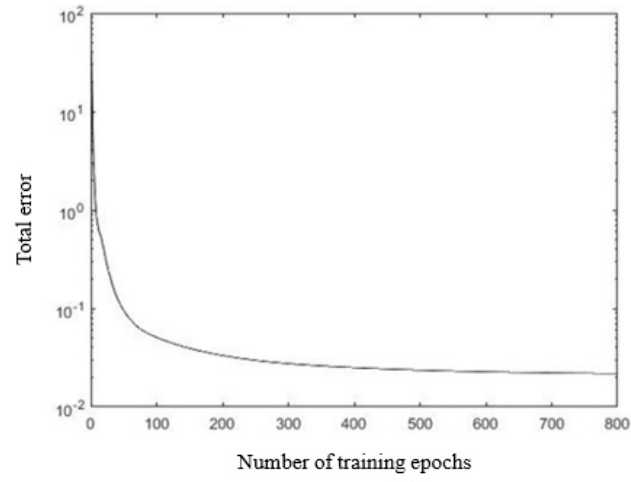
Figure 14. The distribution of sample error.